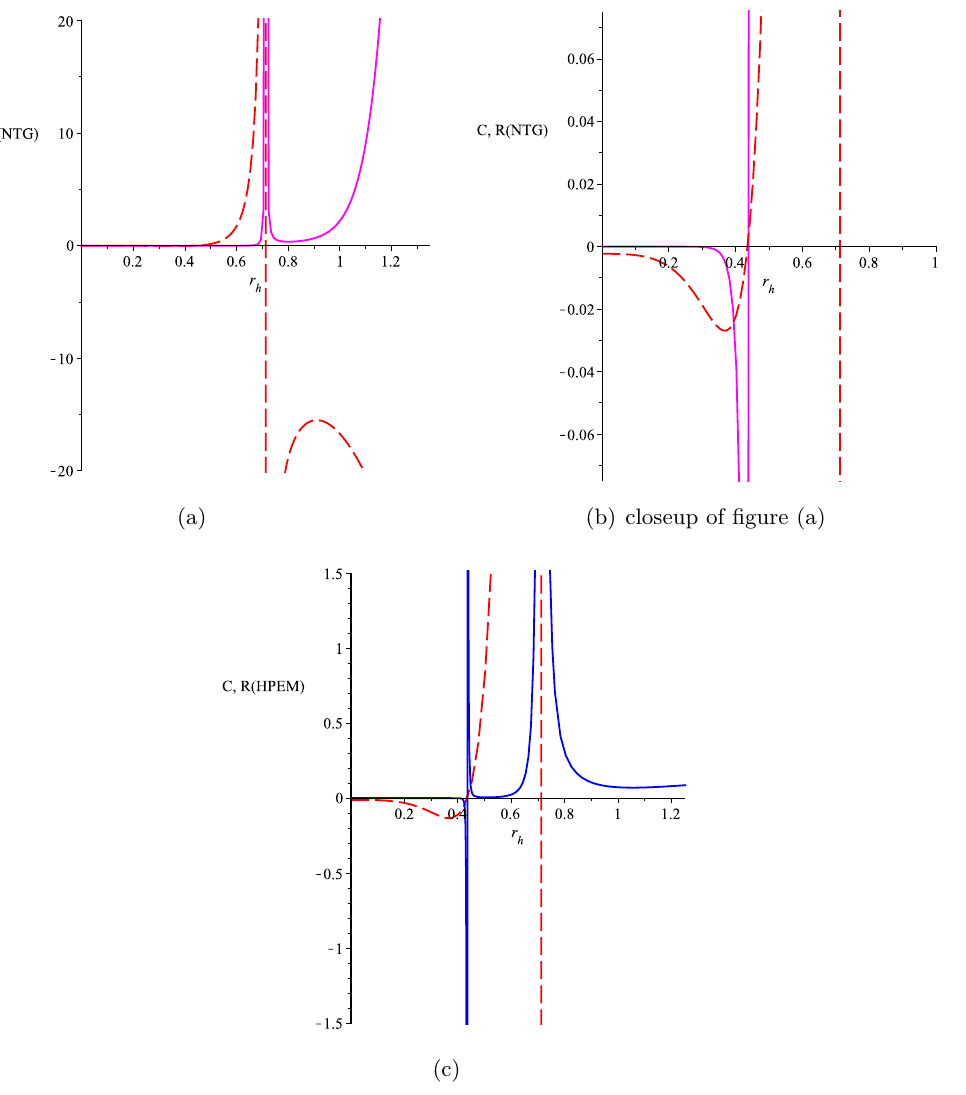
Figure 9 . Scalar curvature of NTG (magenta line) and HPEM (blue line) metrics and also specific heat (red dash line), in terms of horizon radius r h for η = 0 . 95 and J = 0 . 01 , for a Myers-Perry black